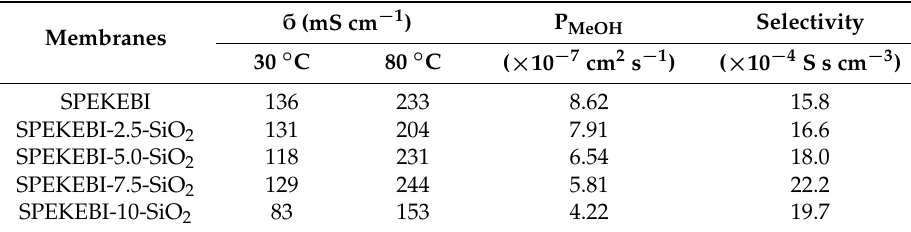
Table 2. Selectivity of SPEKEBI-x-SiO 2 and SPEKEBI membranes.